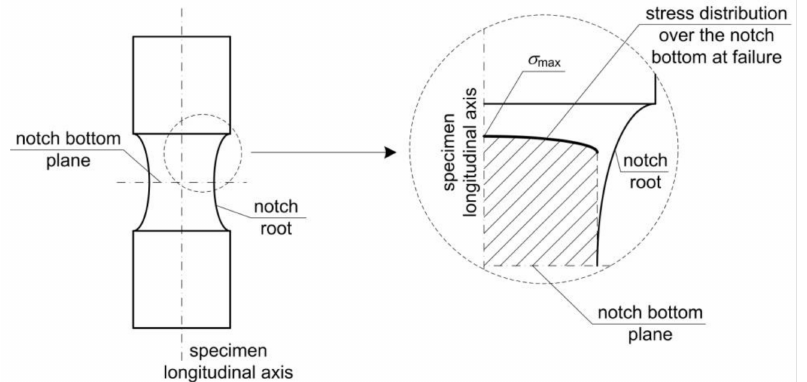
Figure 6. The method of determining the maximum traction in the cohesive model based on the numerically calculated stress distribution over the notch bottom cross section (basing on